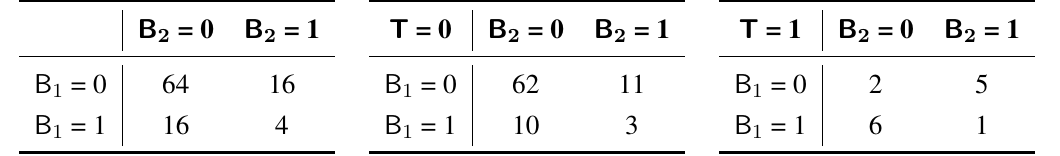
Table 1. Unconditional contingency table of B 1 and B 2 , and conditional contingency tables of B and B given T of datasets RANKIT and RANKITMIX , 1 2